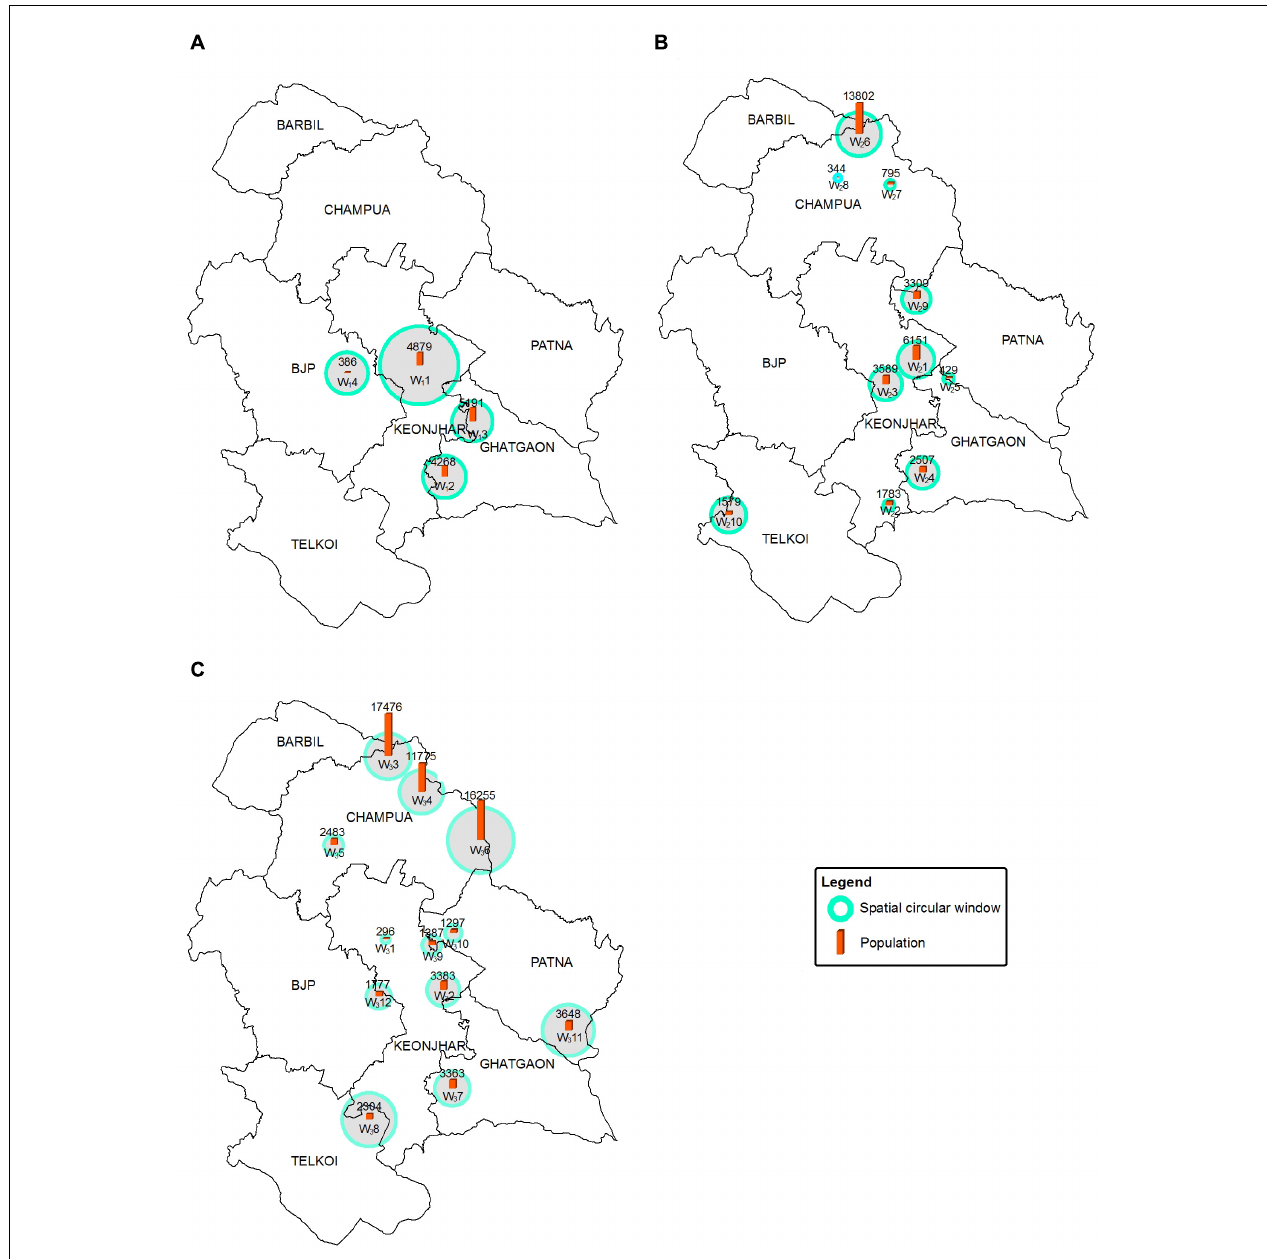
FIGURE 6 | Maps showing the geographical locations of high-risk HEC SCWs for HEC1 (A) , HEC2 (B) and HEC3 (C) where blue circles of radii ranging from 0.5 to 10 km show the SCWs. The red bars plotted within the SCWs show the number of people at risk in each